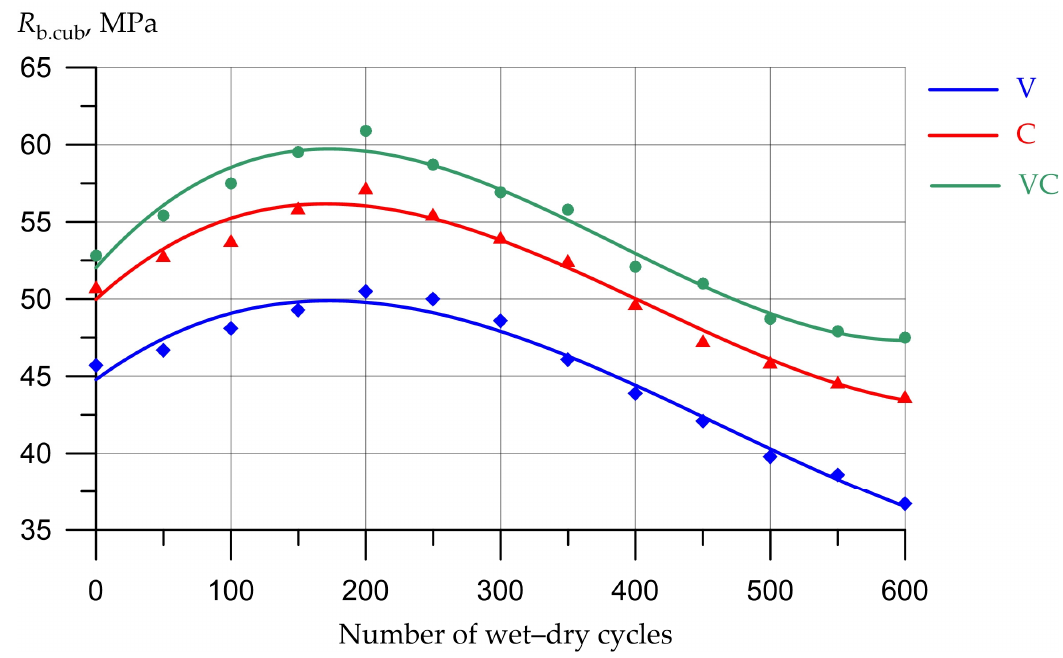
Figure 6. Dependence of the change in the cubic compressive strength of vibrated, centrifuged, and vibrocentrifuged concretes on the number of moisturizing and drying cycles at pH 7.